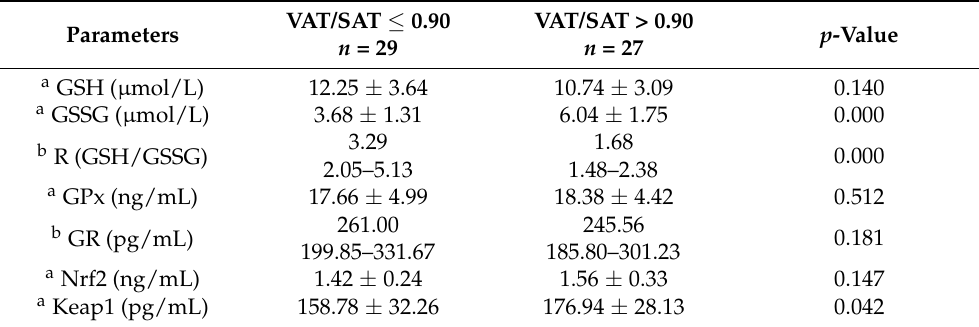
Table 3. Antioxidant defense parameters in women with PCOS divided according to the visceral to subcutaneous fat surface ratio values.